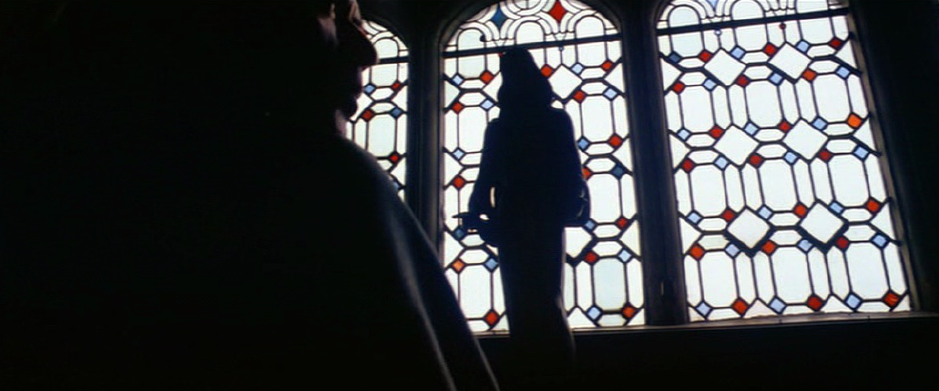
Figure 11: Opechancanough visits the royal chapel in